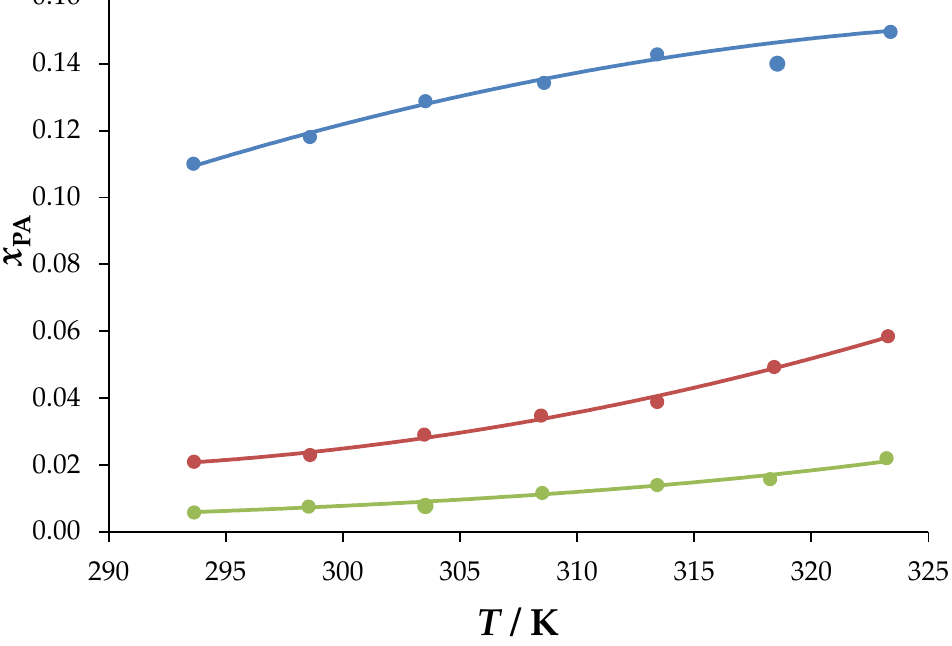
Figure 3. x PA versus T plot of picolinic acid in: H 2 O (blue), EtOH (red), and MeCN (green).